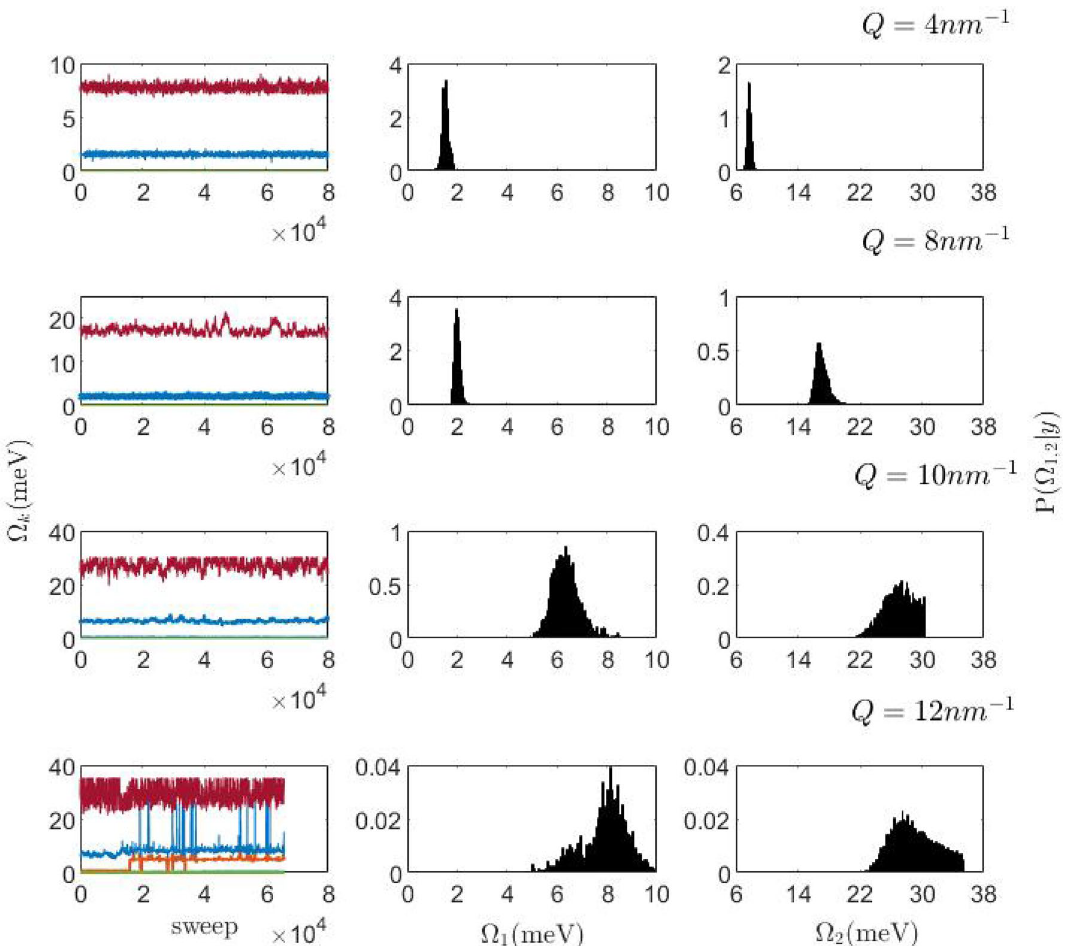
Figure 6. First column: Variation of the (cid:31) value (traceplot) as a function of the algorithm sweeps at four selected values of the exchanged wavevector Q . At the two highest Q ’s the most probable solution predicts three and four modes respectively. Second and third columns: Posterior distributions conditionally on the measured data y for the low (center column) and high (right column) excitation frequencies (see text). To be noticed how the maximum of the posterior density function collapses by orders of magnitude in passing from the case of Q = 4 to the case of Q = 12nm − 1